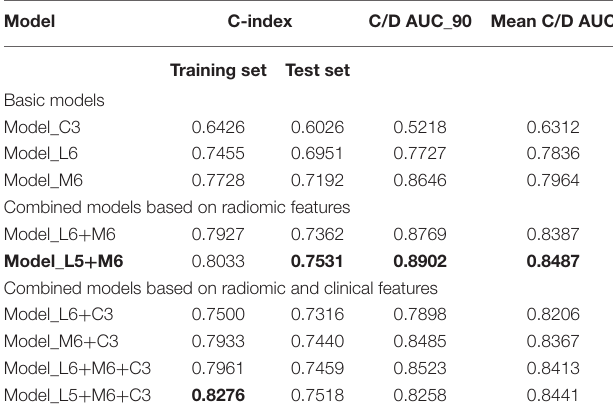
TABLE 3 | Prognostic performance of different survival prediction